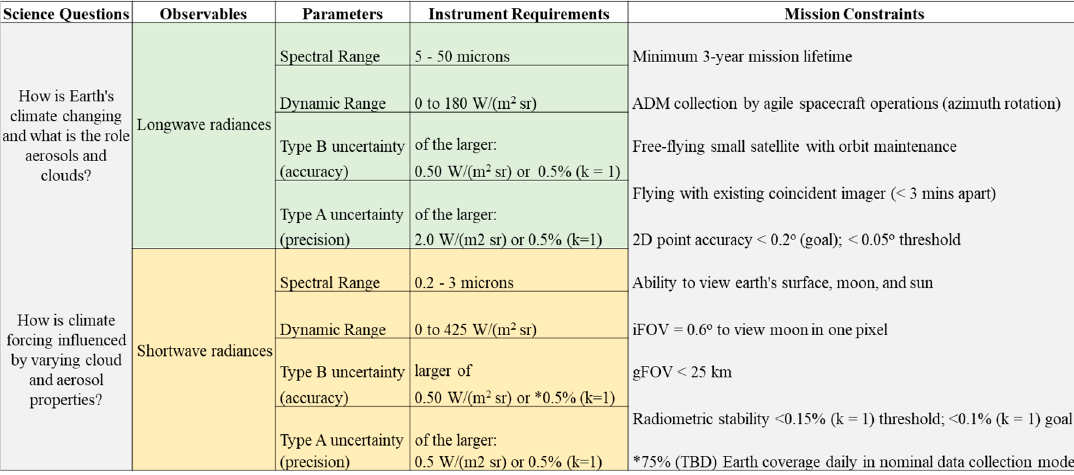
Figure 4. The Trutinor Science Traceability Matrix. Note that to address the science questions, the observables (SW and LW radiances) must be converted to fluxes using Angular Distribution Models (ADMs). * denotes constraints to be investigated as part of a science study.